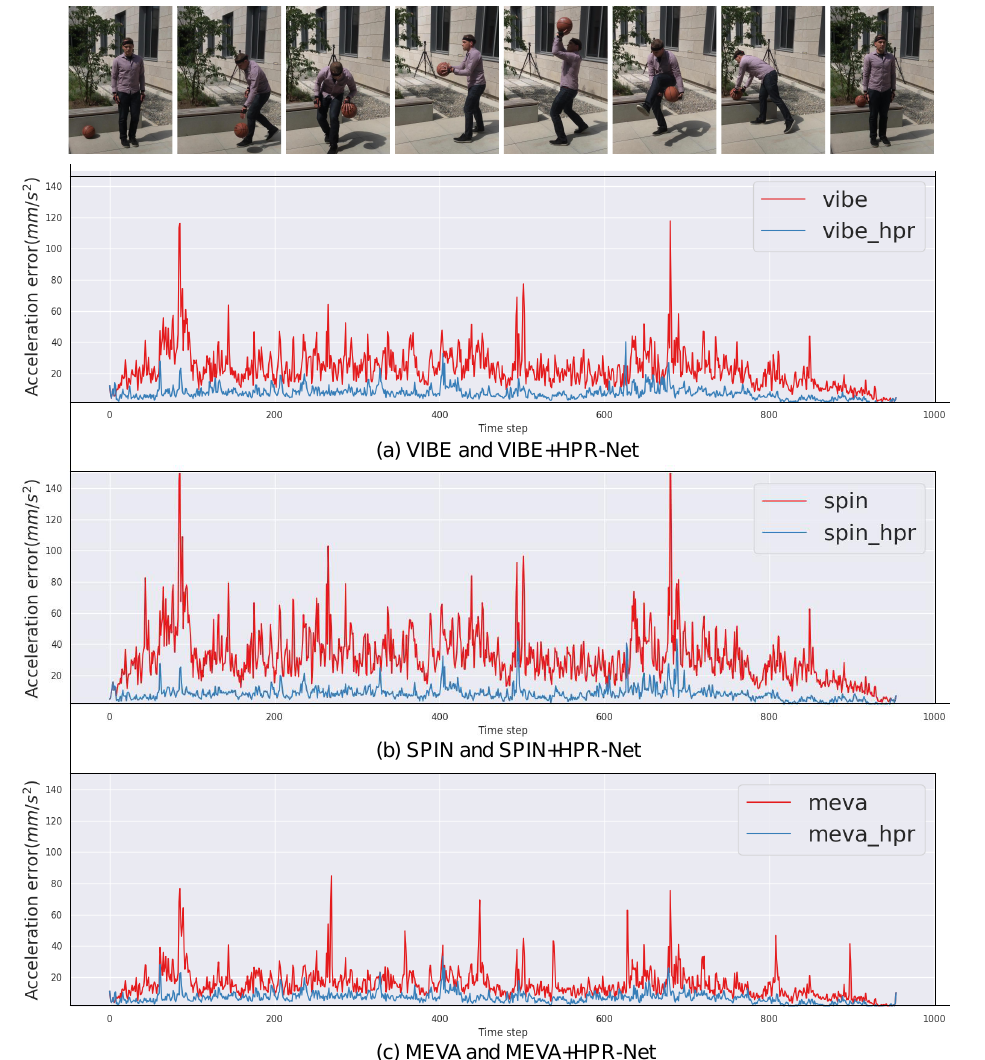
Figure 6. Comparison of acceleration error between HPR-Net and previous methods (VIBE, SPIN, and MEVA). HPR-Net effectively suppresses acceleration error for all methods, even there are very high peaks of acceleration